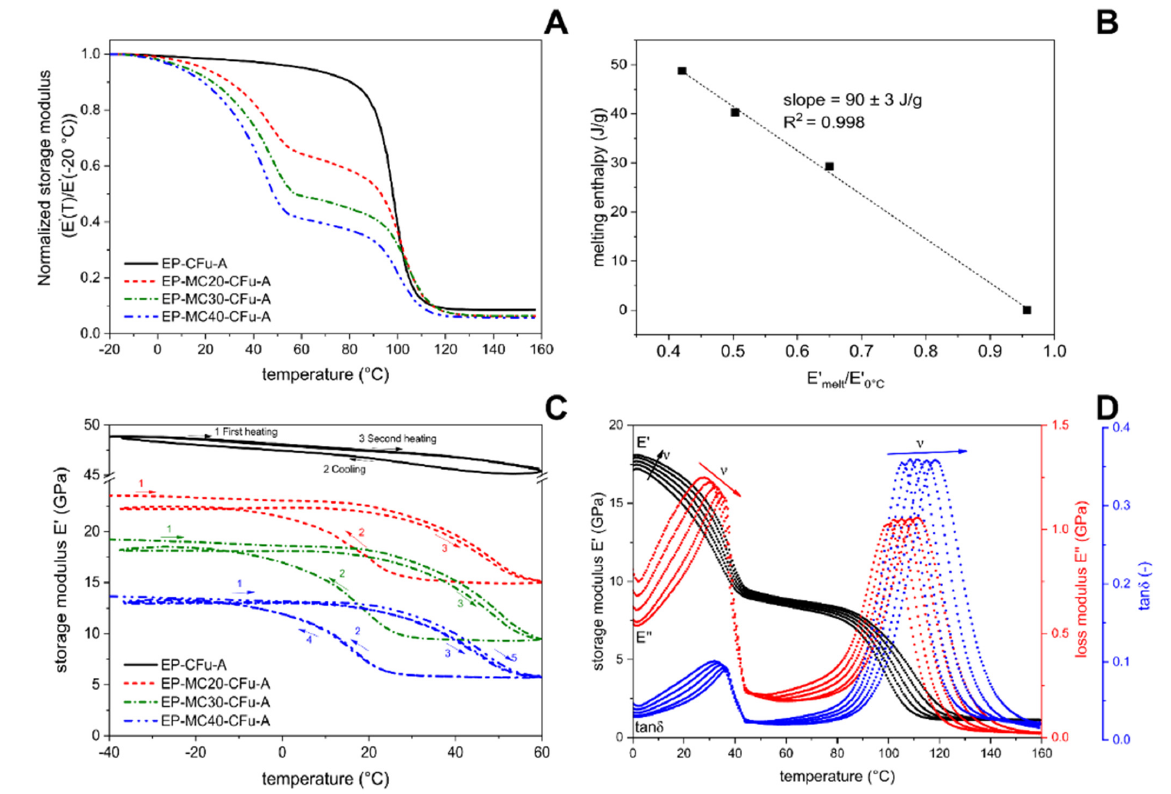
Figure 5. Results of single-cantilever DMTA tests on laminates EP-MCx-CFu-A. ( A ) Single-frequency tests (1 Hz). Storage modulus ( E (cid:48) ) normalized to the value at − 20 ◦ C; ( B ) Single-frequency tests. Value of E (cid:48) after PCM melting (60 ◦ C) normalized to the value at 0 ◦ C, as a function of the melting enthalpy, with the results of the linear fitting; ( C ) Cyclic tests. Storage modulus on a heating–cooling–heating cycle; ( D ) Multi-frequency (0.3-1-3-10-30 Hz) test on the sample EP-MC40-CFu-A. Reprinted with permission from [41].